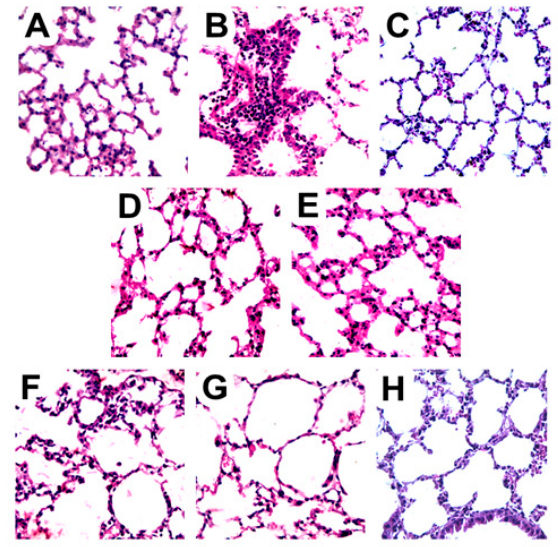
Figure 6. Effects of aqueous extract from the leaves of Aspidosperma pyrifolium and rutin in lung histopathologic changes in VTs-induced peritonitis model. The animals received 100 μ L of VTs intraperitoneal and were treated intravenously, at the same time with saline, AE (40, 50 or 60 mg/kg) or rutin (2.5 or 5 mg/kg). Six hours after envenomation induction, the animals were euthanized and had their lungs removed, processed and analyzed by hematoxylin and eosin staining on optical microscope (40×): ( A ) saline (intraperitoneal) and saline (intravenous); ( B ) VTs (intraperitoneal) and saline (intravenous); and ( C – H ) animals treated (intravenous) with: ( C ) SAAV 50 μ L; ( D ) rutin 2.5 mg/kg; ( E ) rutin 5 mg/kg ( F ) AE 40 mg/kg; ( G ) 50 mg/kg and ( H ) 60 mg/kg.